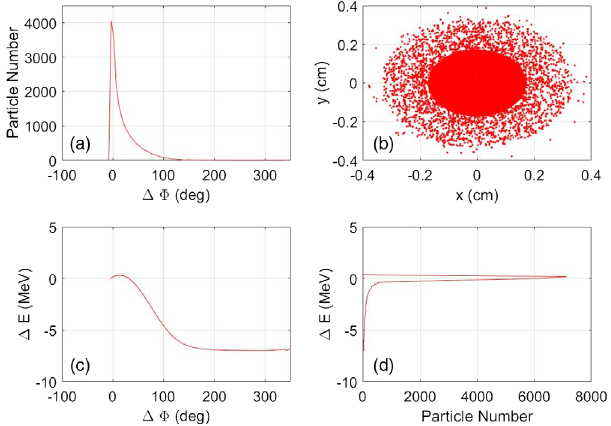
FIG. 10. T - STEP output electron beam parameters. (a) Longi- tudinal phase distribution in degrees; (b) beam transverse spot size in cm; (c) beam longitudinal phase-space (energy vs phase); (d) beam energy spectrum in MeV.